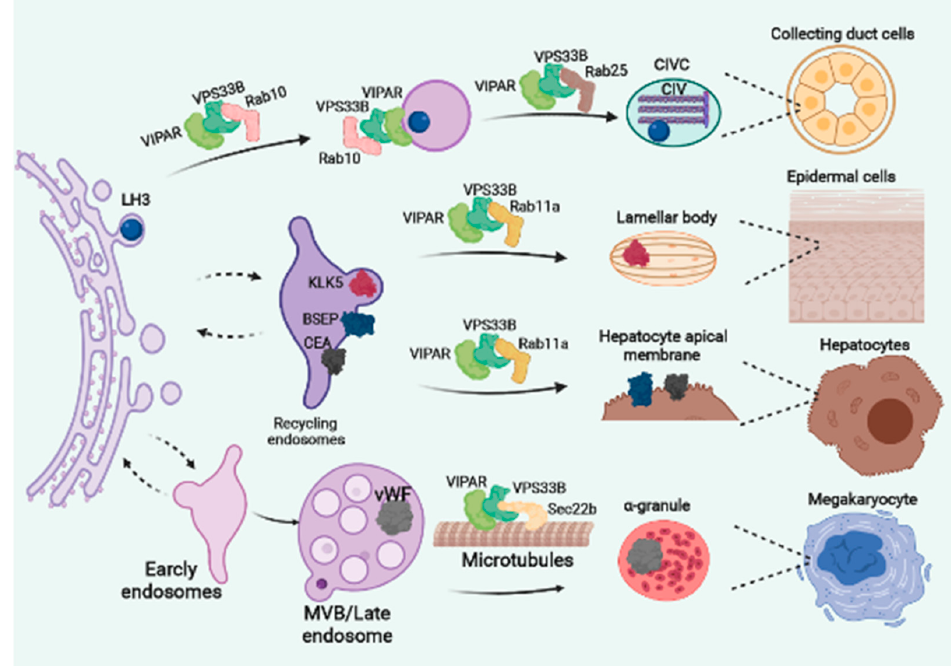
Figure 6. CHEVI complex regulates delivery of different cargoes in different intracellular compart- ments. The VPS33B/VIPAR protein complex delivers lysyl hydroxylase 3 (LH3) to collagen IV carriers (CIVC) in Collecting duct cells, Kallikrein-related peptidase 5 (KLK5) from the recycling endosomes to lamellar bodies in epidermal cells, bile salt export pump (BSEP) and the carcinoembryonic antigen (CEA) from the recycling endosomes to the hepatocyte apical membrane in hepatocytes and von Willebrand factor (vWF) from multivesicular bodies to α -granules through the interaction with α -tubulin and SEC22B.